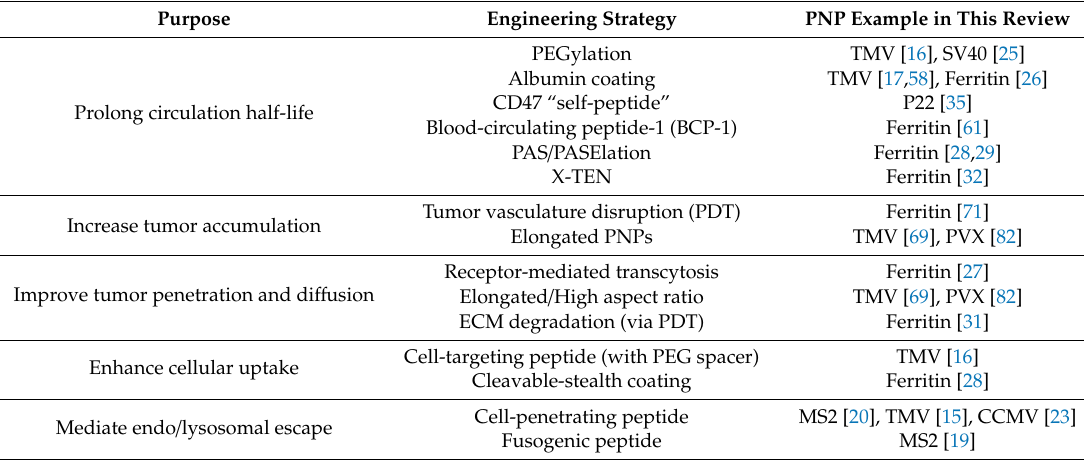
Table 2. Engineering strategies used to maximize PNP delivery in